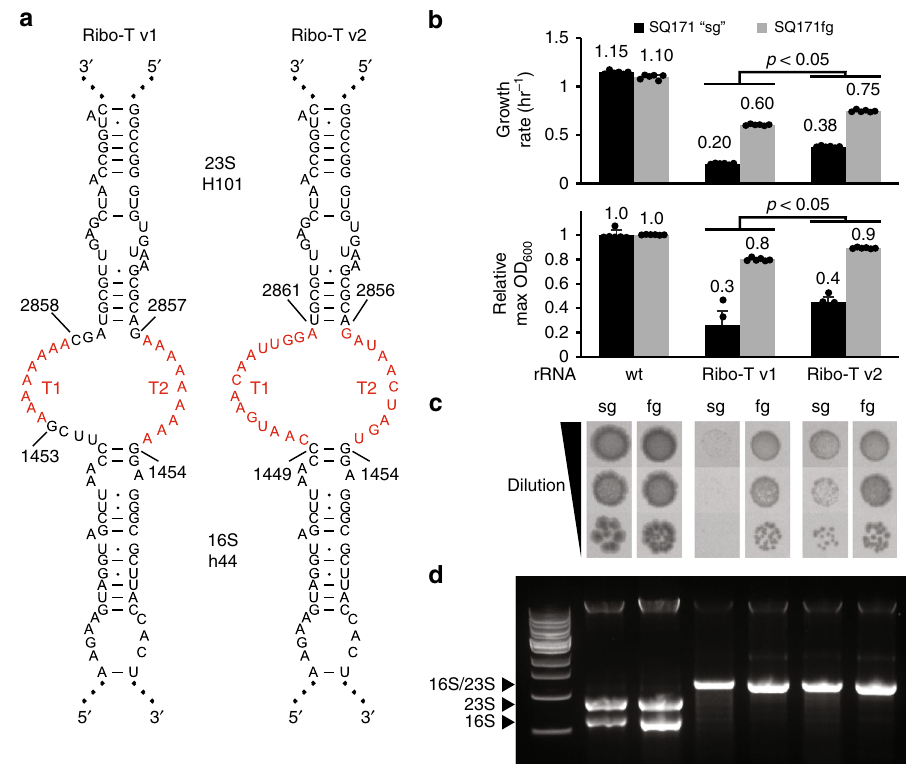
Fig. 3 Optimizing tether sequence improves performance. a Ribo-T v1: previously published tether sequence. Ribo-T v2: fastest growing and most frequent selected tether sequence. b Growth rate and max OD 600 of SQ171 slow growing (sg) and SQ171 and fast growing (fg) cells growing with pAM552 (wild- type rrnb operon), pRibo-T v1 and pRibo-T v2 ( n = 6; paired t -test [two-sided], p < 0.05). Error bars = 1SD. c Spot plated SQ171 and SQ171fg cells growing with pAM552, pRibo-T v1 and pRibo-T v2 imaged after 48 h at 37 °C. d Total RNA extraction from SQ171 and SQ171fg cells growing with pAM552, pRibo-T v1 and pRibo-T v2. Source data for b – d can be found in the Source Data fi